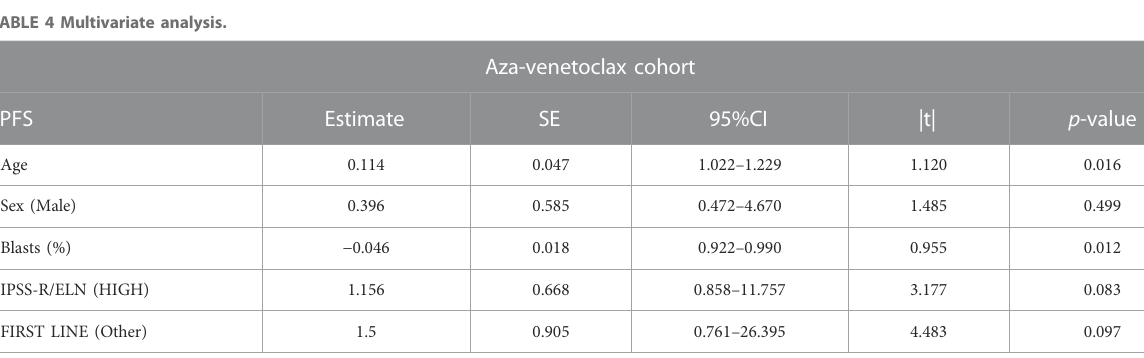
TABLE 4 Multivariate